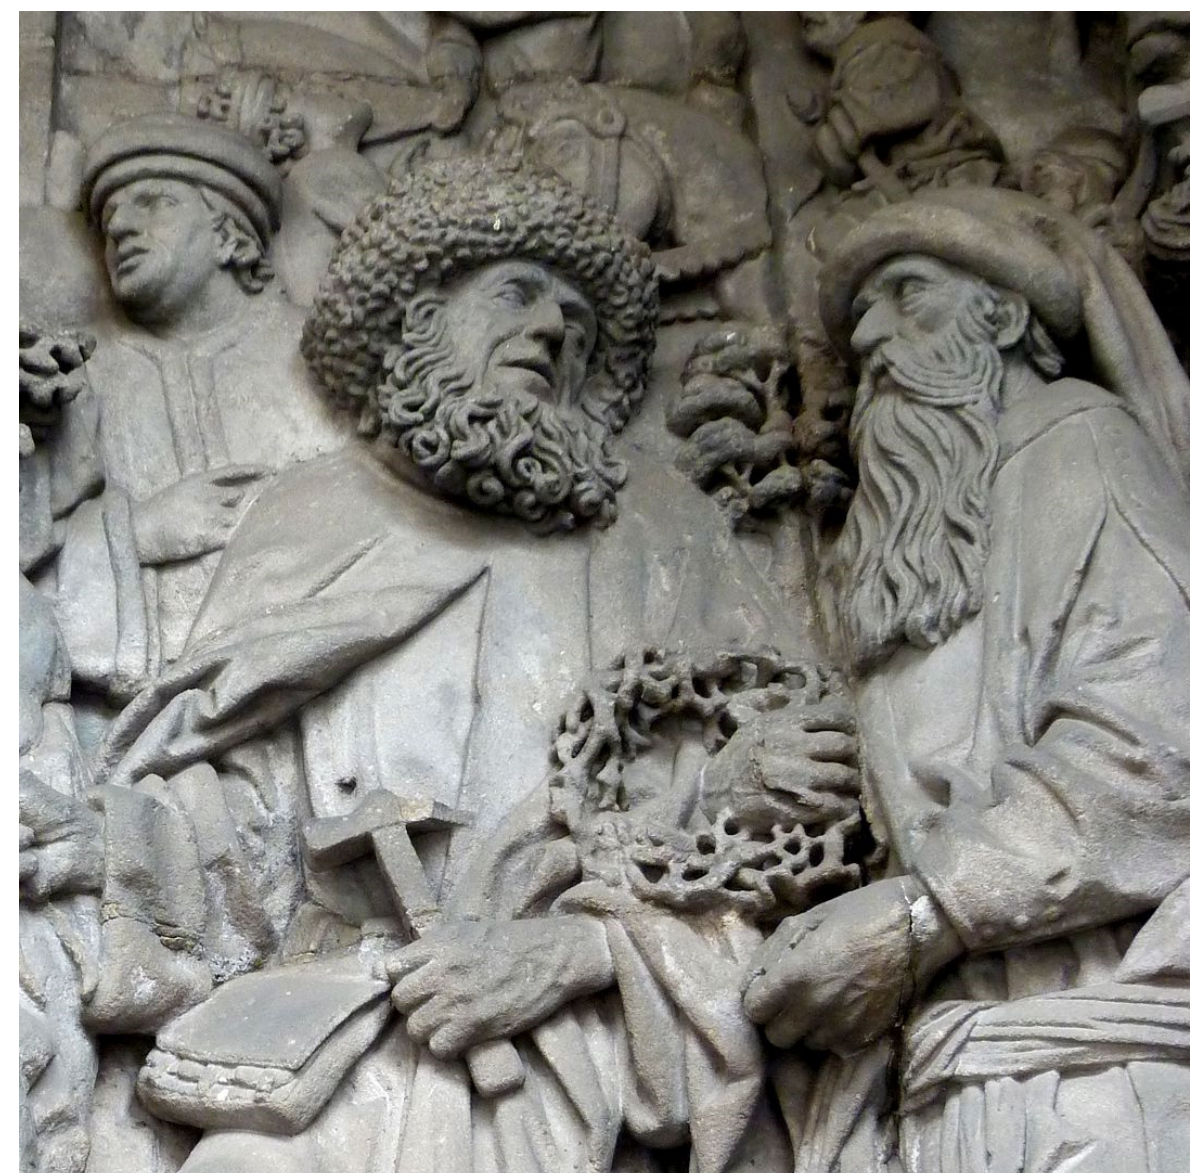
Figure 7. Kraft, Schreyer–Landau Epitaph, Detail: Nicodemus (Self-Portrait) and Joseph of Arimathea from Deposition